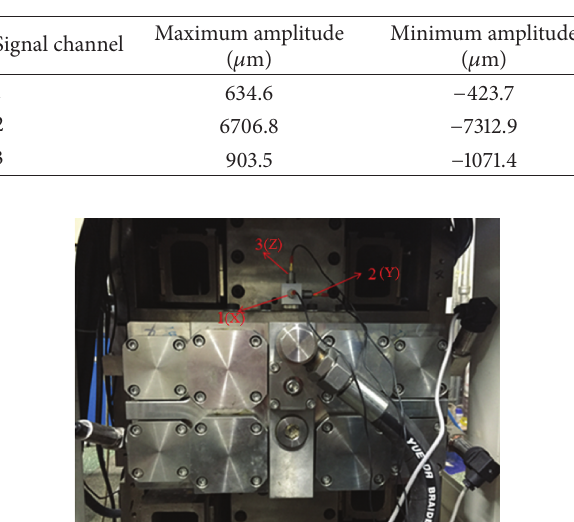
Table 4: Vibration amplitude of each channel under the S wave motion curve.